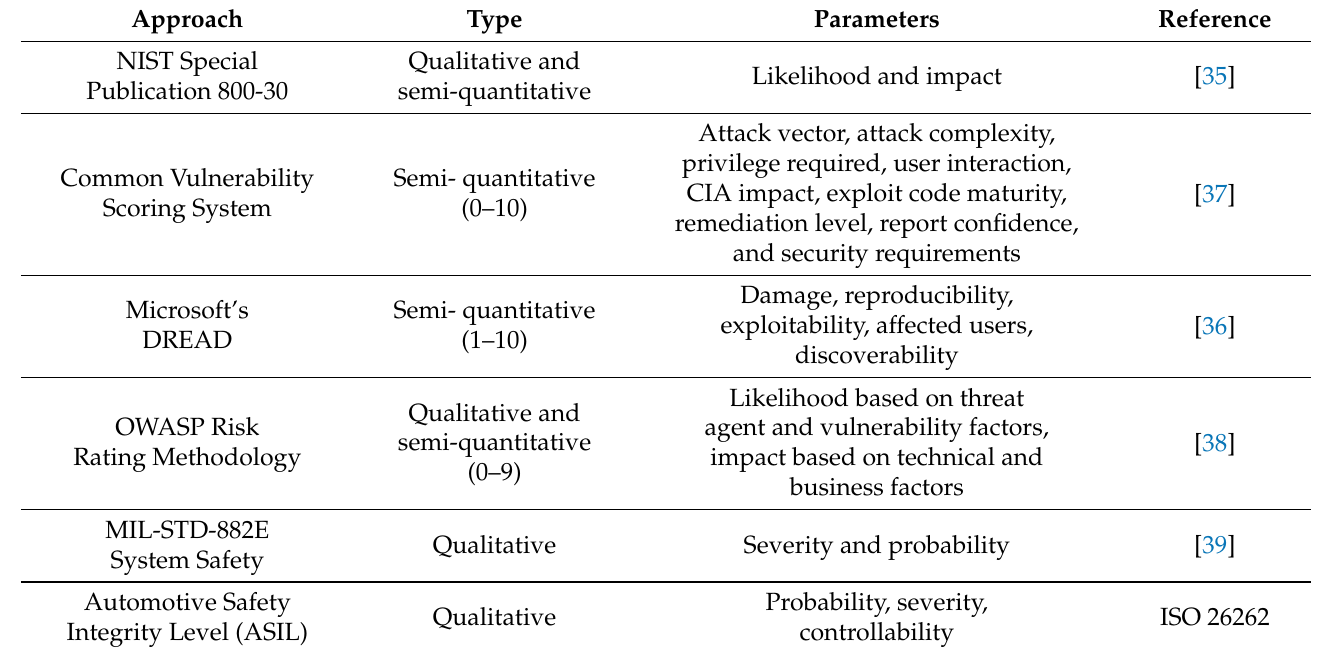
Table 1. The most relevant quantitative, qualitative and semi-quantitative approaches proposed in the